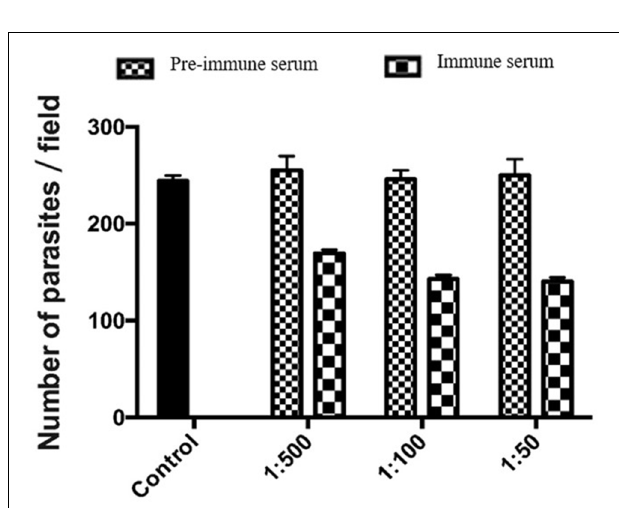
FIGURE 5 | Inhibition of Cryptosporidium parvum invasion of HCT-8 cells by polyclonal MEDLE-2 antibodies. Data presented are mean ± SD parasites per 200 X field based on numbers from 30 randomly selected microscopy fields of C. parvum cultures. Control, C. parvum culture maintained in growth medium alone; 1:500, C. parvum culture with the addition of pre-immune or immune serum 1:500 dilution; 1:100, C. parvum culture with the addition of pre-immune or immune serum 1:100 dilution; 1:50, C. parvum culture with the addition of pre-immune or immune serum 1:50